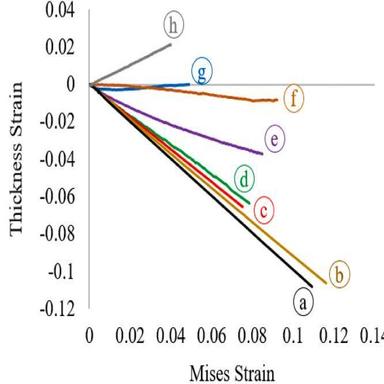
Thickness strain evolution of the pole section of the tubes under biaxial deformation modes a-h.